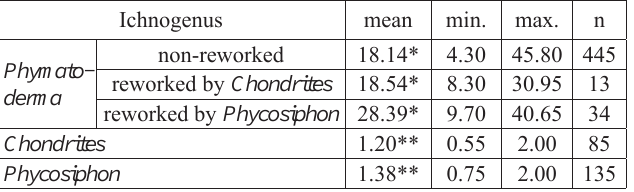
Table 1. Diameters (in mm) of trace fossils within the host siltstone of the Pliocene Shiramazu Formation, central Japan. n, number of measured burrows; * Phymatoderma reworked by Phycosiphon has significantly (p <0.001) larger diameter than Phymatoderma without reworking or reworked by Chondrites , whereas mean diameter of Phymatoderma re- worked by Chondrites has no significant difference from non-reworked Phymatoderma ; ** Phycosiphon has significantly (p <0.001) larger mean dia meter than Chondrites . Ichnogenus mean min.